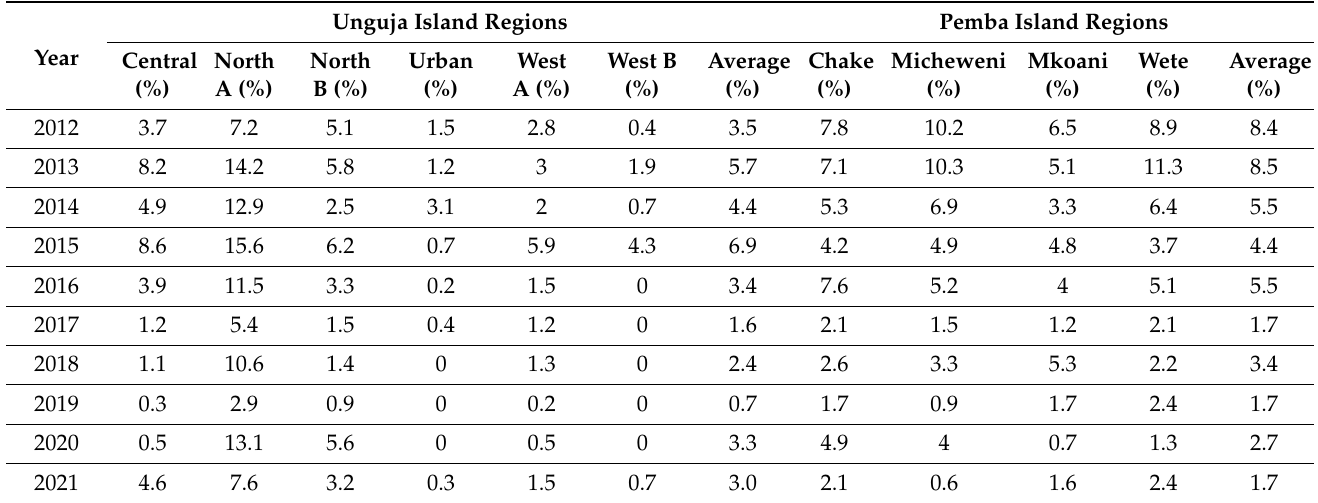
Table 1. Prevalence of S. haematobium infection in the Unguja and Pemba islands from 2012–2021. Unguja Island Year